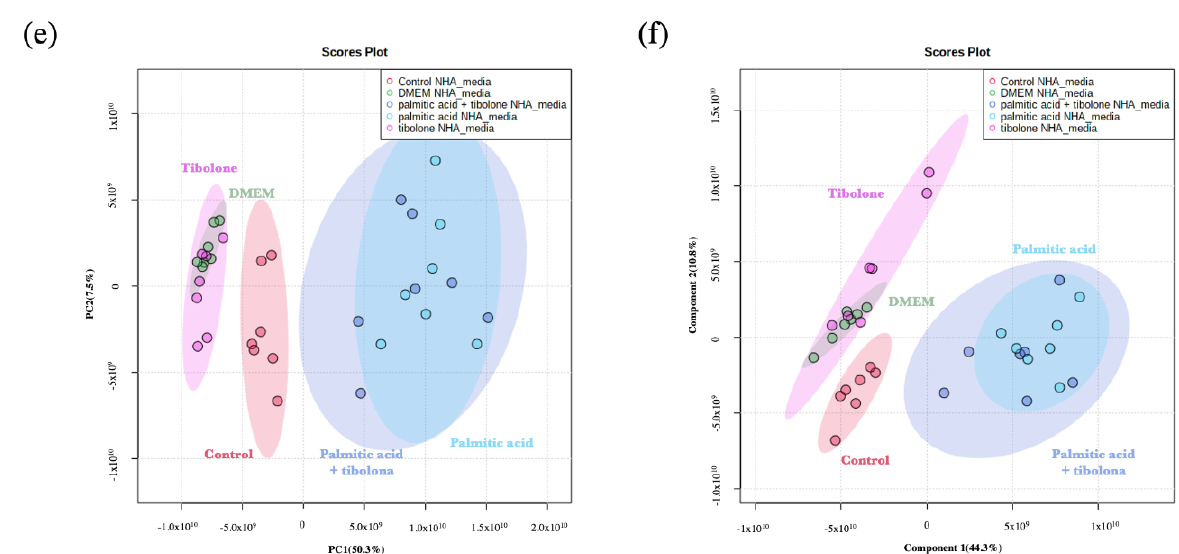
Figure 1. Analysis for the complete data set ( a ) Principal component analysis to complete data for (left) endometabolome, the color patterns correspond to DMEM (blue), palmitic acid + tibolone (magenta), tibolone (light green), control (red), palmitic acid (purple). The exometabolome (right) represent palmitic acid (orange), control (dark green), DMEM (light blue), tibolone (pink) and palmitic acid + tibolone (yellow). ( b ) Partial least squares discriminant analysis for (left) endometabolome and (right) exometabolome. The color patterns are the same as PLS-DA. ( c , d ) Specific analysis for the endometabolome ( c ) Principal component analysis and ( d ) partial least squares discriminant analysis, where treatments are represented with tibolone (pink), control (red), DMEM (light green), palmitic acid (light blue), palmitic acid + tibolone (dark blue). ( e , f ) Specific analysis for the exometabolome. The pattern colors are the same as the endometabolome